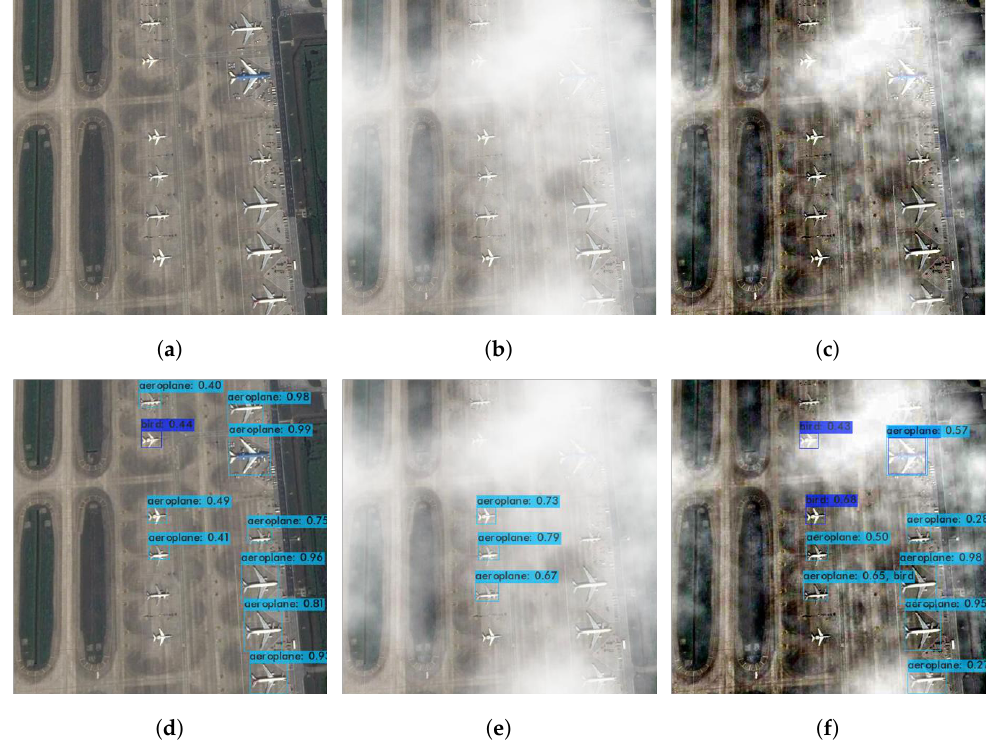
Figure 1. Illustration of the negative effects of cloud and beneficial effects of image dehazing on an aerial surveillance application. First row: ( a ) a clean image and its corresponding ( b ) synthetic cloudy image and ( c ) dehazed result. Second row: ( d – f ) results obtained after processing ( a – c ) using a YOLOv4-based high-level object recognition algorithm. Notes: cyan labels represent airplanes, and navy-blue labels represent